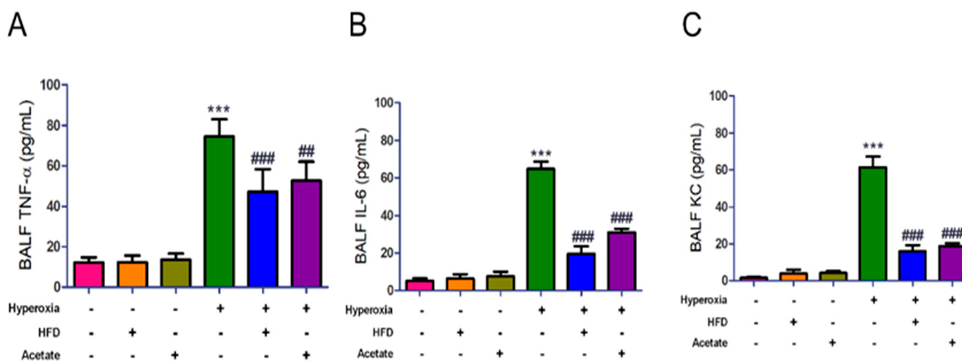
Figure 4. A high-fiber diet and acetate supplementation alleviate production of inflammatory mediators in the bronchoalveolar lavage fluid (BALF) of mice exposed to hyperoxia. ELISAs of TNF- α ( A ), IL-6 ( B ), and KC ( C ) in BALF. Data are mean ± SD (six mice per group). *** p < 0.001, compared with the ambient air group; ## p < 0.01, ### p < 0.001 compared with the hyperoxia group.